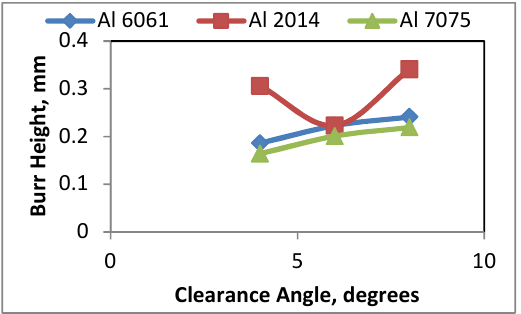
Fig. 15. Influence of variation of the clearance angle on Fig. 16. Variation in the clearance angle effect on burr